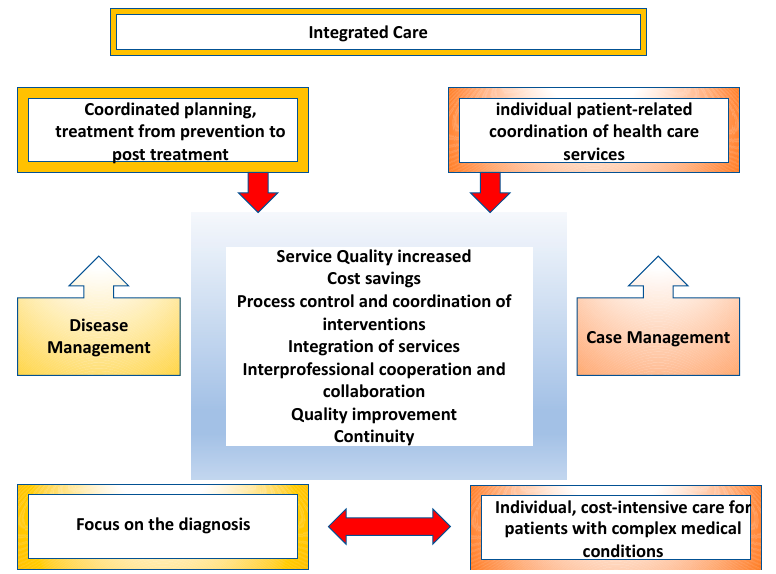
Figure 2. Integrated care, disease management, case management (own presentation; data from Bower, 2014; Taylor, Candy, and Bryar, 2005) [68,69].